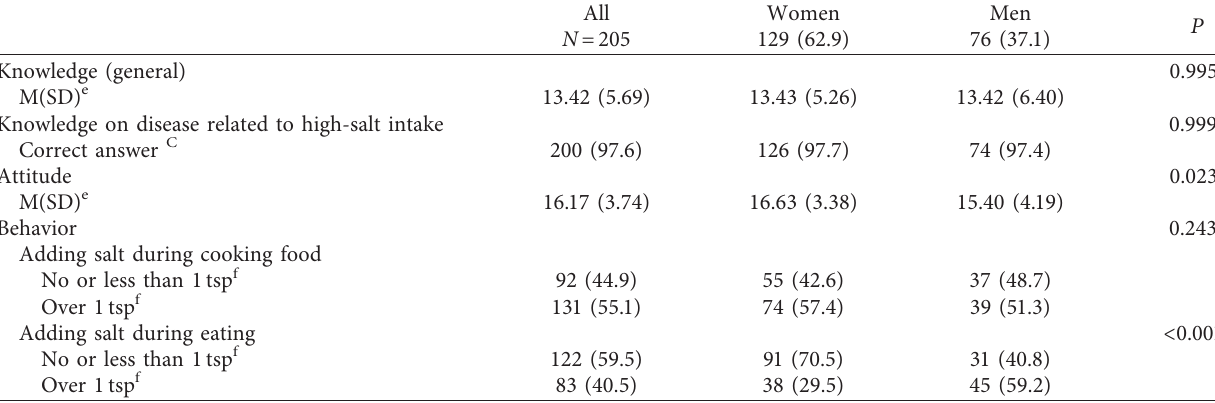
Table 3: Patients’ knowledge, attitude, and behavior.